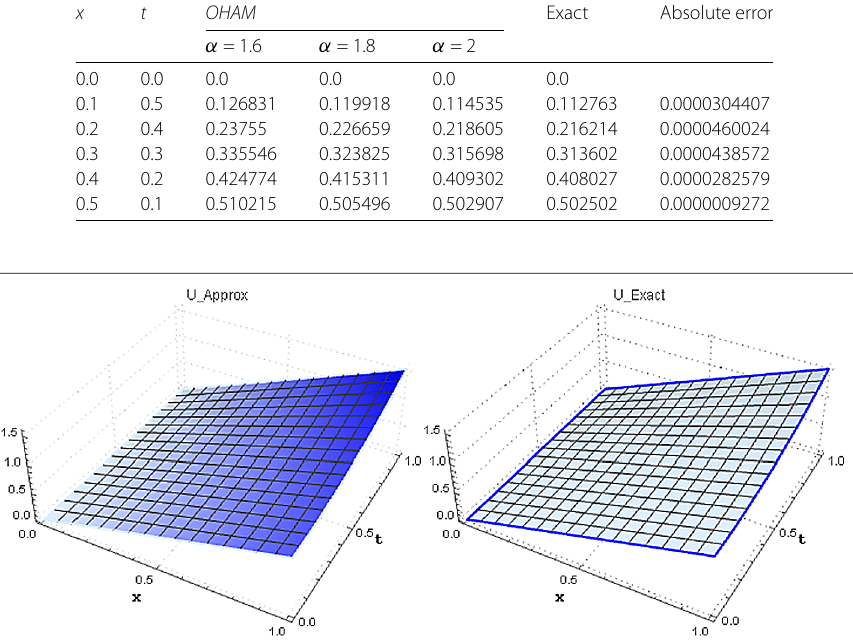
Figure 2 Comparison of the third-order approximate solution (4.9) with exact solution for α =